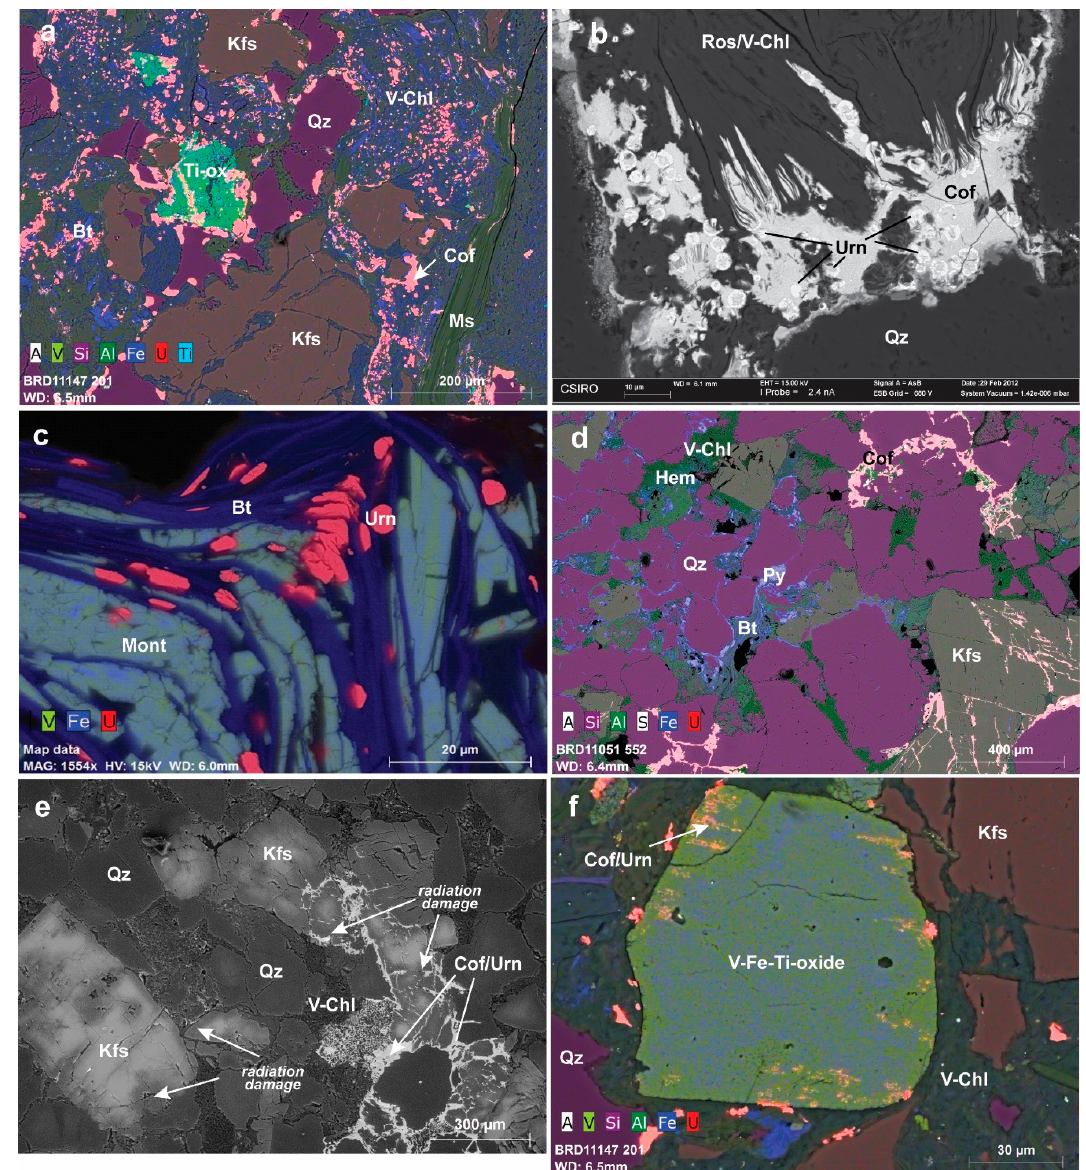
Figure 8. BSE-EDS micrographs illustrating U-mineral textures. ( a ) Fine, disseminated uraninite/coffinite (pink) resides within Fe-clay-rich matrix and partly replaces Fe-Ti-V oxides (green); coffinite also replaces the margins of quartz grains; ( b ) on a quartz–mica grain contact, coffinite (light grey) replaces quartz and invades mica cleavage planes; globular uraninite has been partly replaced by coffinite leaving disc-shaped remnants of about 5 microns diameter; ( c ) uraninite crystallites (red) decorate the cleavage planes of altered biotite (dark blue) in association with bladed montroseite crystals (light blue–green); ( d ) coffinite (pink) fills fractures in K-feldspar and replaces the margins of some quartz grains; fine pyrite (light blue) occurs separately from coffinite mainly within the clay-rich matrix and as thin coatings on some grain boundaries. ( e ) Composite CL/BSE image showing strong radiation damage features in fractured K-feldspar; the absence of fracture-filling uranium minerals in part of the section indicates loss of U; ( f ) detrital Fe-Ti oxide grain showing partial replacement by V and U (Ti not shown in Figure).